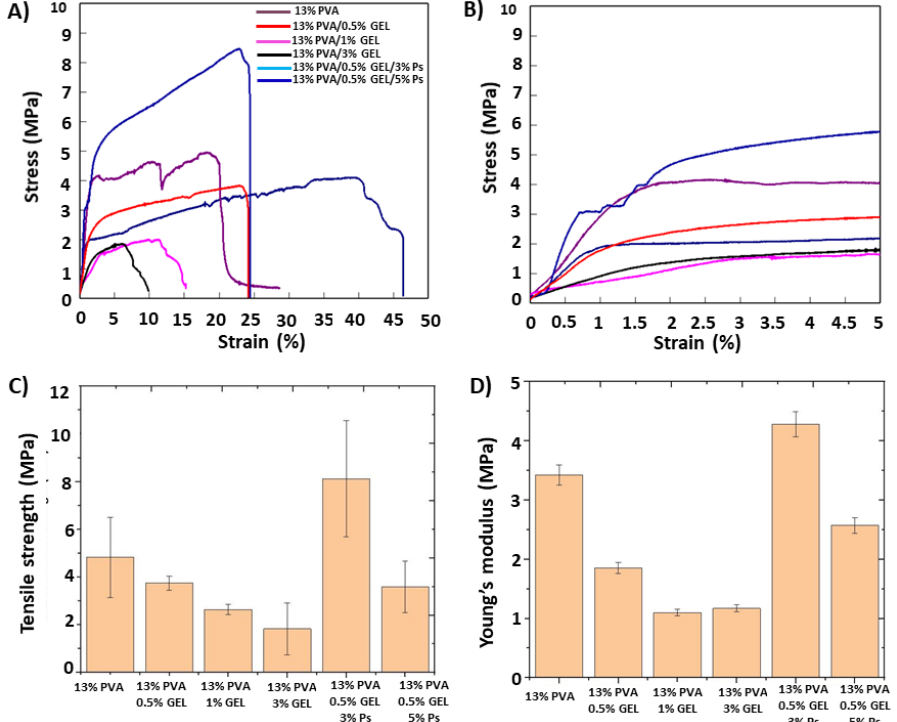
Figure 5. The typical stress/strain curve of the all-nanofiber patches using mean values of three measurements from each other ( A , B ), tensile strength ( C ), and calculated Young’s modulus values ( D ) using the linear region of stress strain curve ( B ).